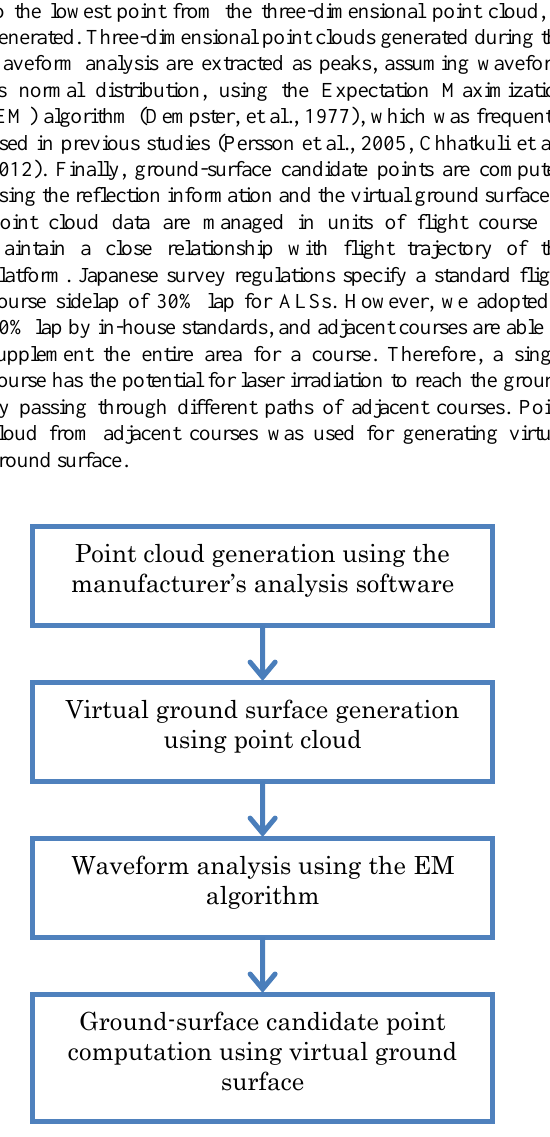
Figure 9. Flawchart of the proposed method